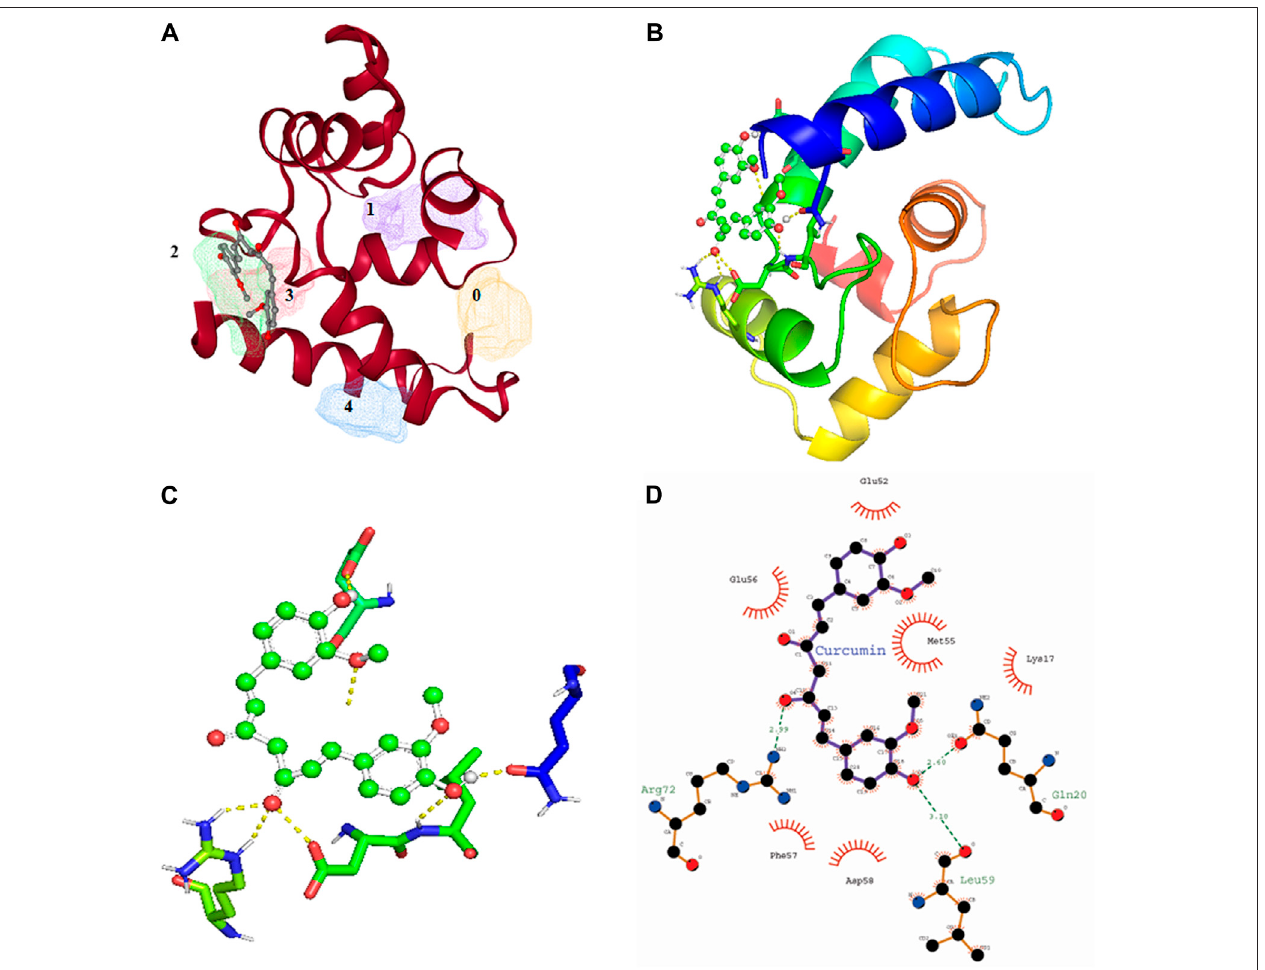
FIGURE 3 | Molecular docking showing the interaction of Iba1 protein with Curcumin. (A) DoGSiteScorer analysis for predicting potential drug binding sites (pockets) on protein 3D structure. Out of 5 pockets for drug binding detected, Curcumin has been observed to fall in pocket 2 (green). (B, C) Pymol analysis of protein- ligand interaction after molecular docking using Autodock. The dotted yellow line indicates hydrogen bonding between Iba1 and Curcumin. (D) LigPlot Plus analysis of Autodock result generated 2D ligand-protein interaction diagram depicting hydrogen bonds between Iba1 Gln20, Leu59 and Arg72 amino acids with Curcumin. The hydrogen bond has been shown in green dotted line with a distance of protein and ligand hydrogen bond mentioned in Angstroms (Å).